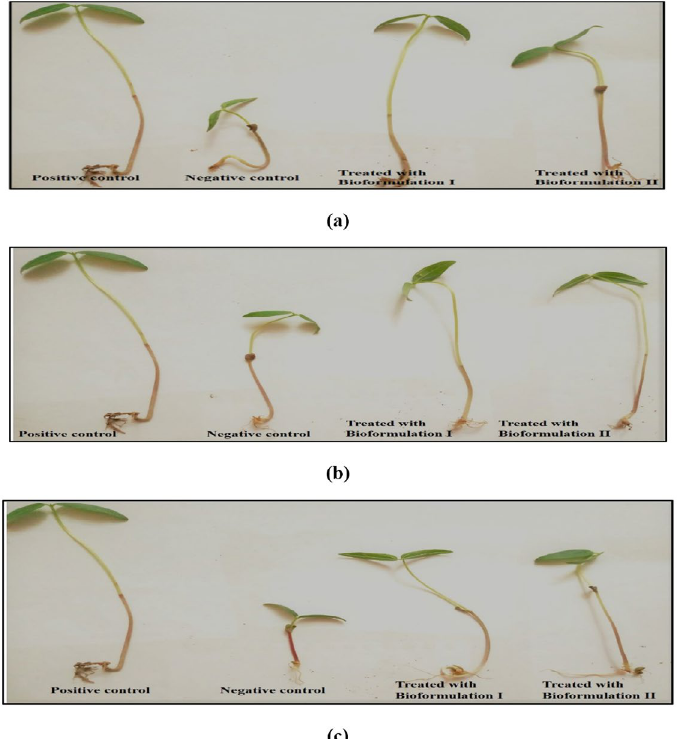
Fig. 9. Plant Growth of Vigna radiata in samples of a) Electroplating industry b) Battery industry c) Steel